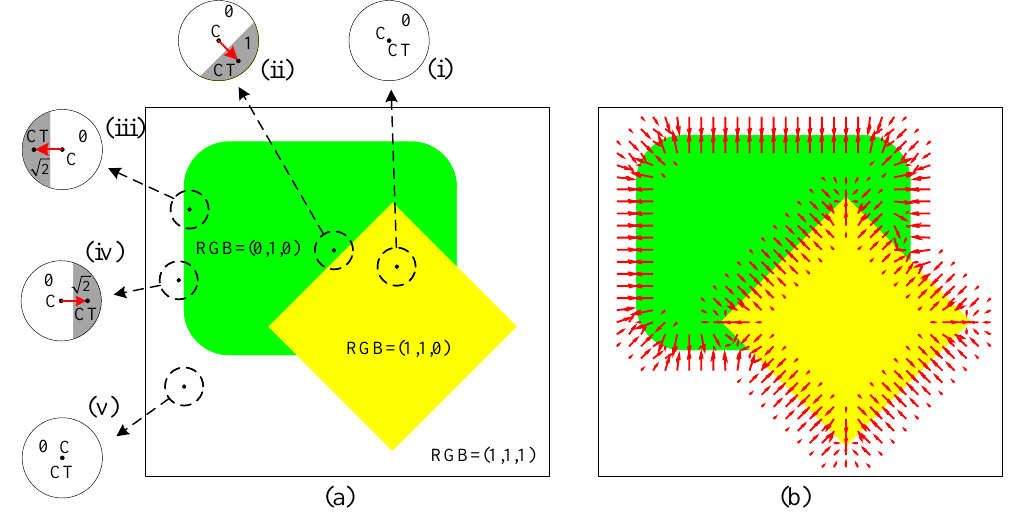
Figure 3. ( a ) local color distance images and ( b ) a normal compressive vector field obtained from ( C - to - CT )